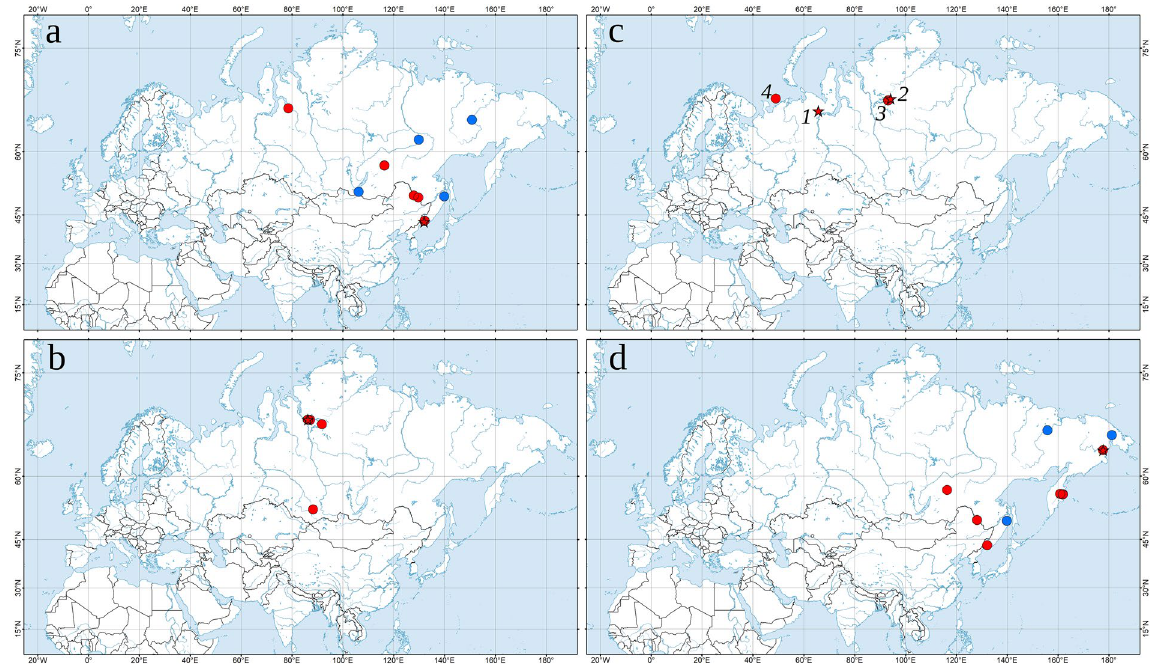
Figure 7. Maps of the type localities and occurrences of the new Glossiphoniidae species. ( a ) Alboglossiphonia sibirica sp. nov. ( b ) Glossiphonia taymyrensis sp. nov. ( c ) G. arctica sp. nov. ( 1 ) and Hyperboreomyzon polaris gen. & sp. nov. ( 2–4 ). ( d ) Helobdella okhotica sp. nov. The red stars indicate the type localities; the red circles indicate original records; the blue circles indicate published records (see Supplementary Dataset 2 for raw occurrence data and literature sources). The map was created using ESRI ArcGIS 10 software (www. esri. com/